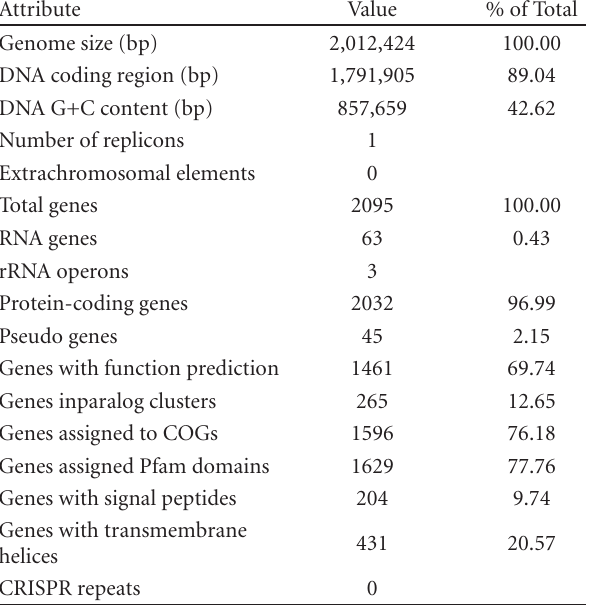
Table 1: Genome Statistics.